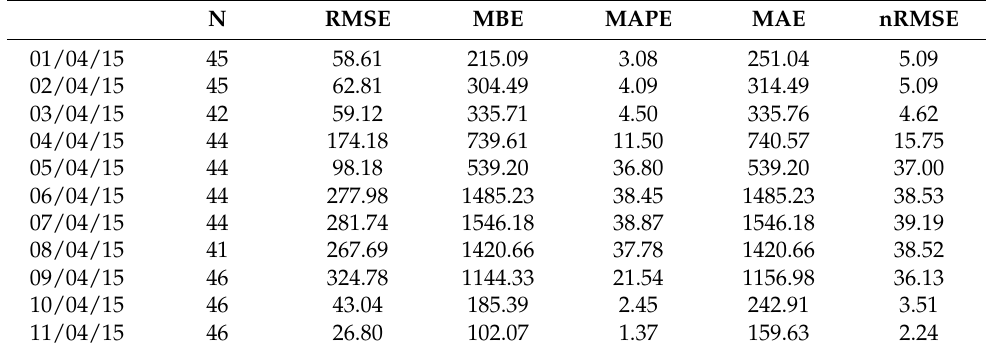
Table 5. Statistical metrics of inverter 8 of the same PVS1 from 1 April 2015 to 11 April 2015 for abnormal